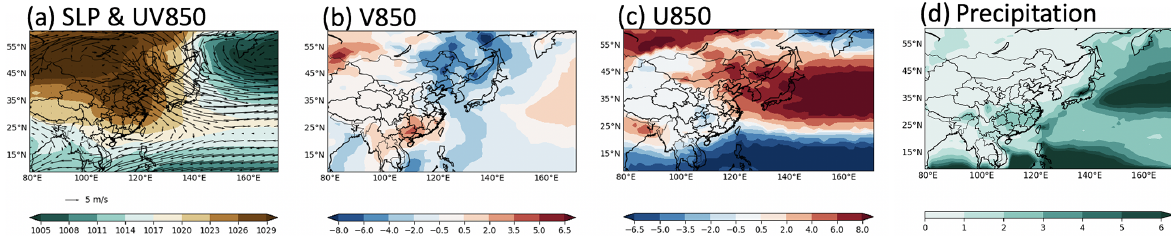
Figure 4. Simulated winter mean daily (a) sea level pressure (SLP; hPa, shading) and 850hPa wind (arrows), (b) 850hPa meridional wind (V850; ms − 1 ), (c) 850hPa zonal wind (U850; ms − 1 ), and (d) precipitation (mmd − 1 ) from nudged UKESM1 during DJF 1999–2018.